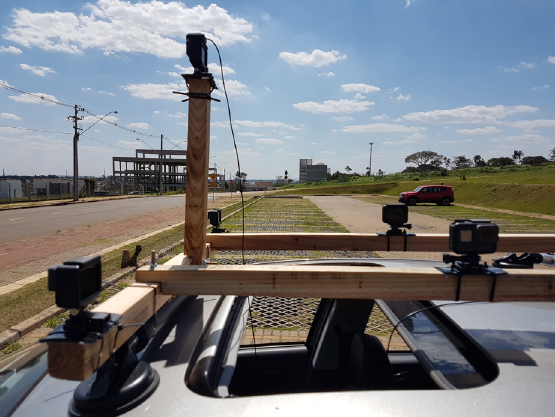
Figure 2. Vehicle and base for the GoPro